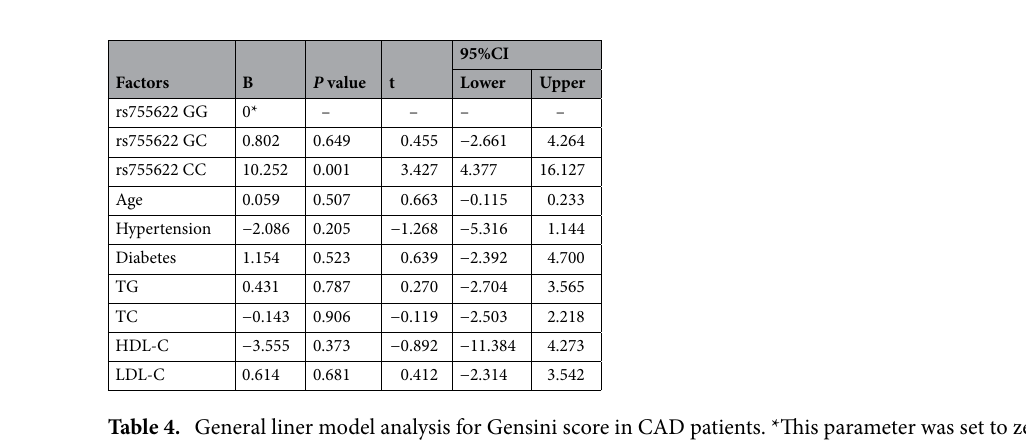
Table 4. General liner model analysis for Gensini score in CAD patients. *This parameter was set to zero because it was redundant.